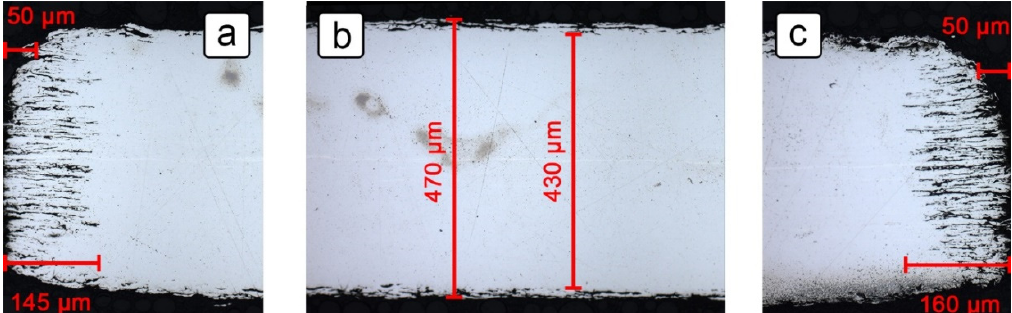
Figure 5. The cross-section reduction of the grade 316L after 28 days of exposure in the 10% H 2 SO 4 solution containing 5000 mg/L NaCl at 65 °C and at room temperature: ( a ) left edge of a 0.5 mm thick steel sheet; ( b ) middle section of a 0.5 mm thick steel sheet; ( c ) right edge of a 0.5 mm thick steel sheet.